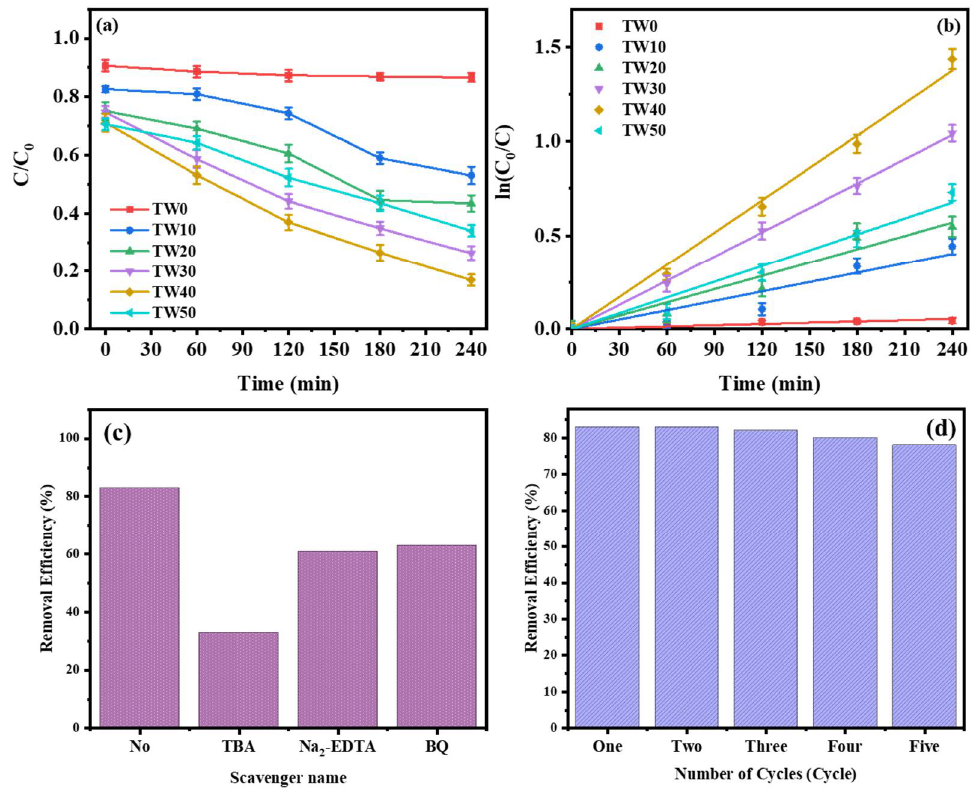
Figure 5. ( a ) Photocatalytic degradation of phenol for prepared nanofibers under visible light irradiation; ( b ) the ln(C/C0) changing versus time during visible light irradiation for prepared nanofibers; ( c ) Trapping test of the photogenerated free radicals and holes with TW40 nanofibers; ( d ) The stability cycles of phenol photodegradation using TW40 nanofibers under visible light irradiation for 4